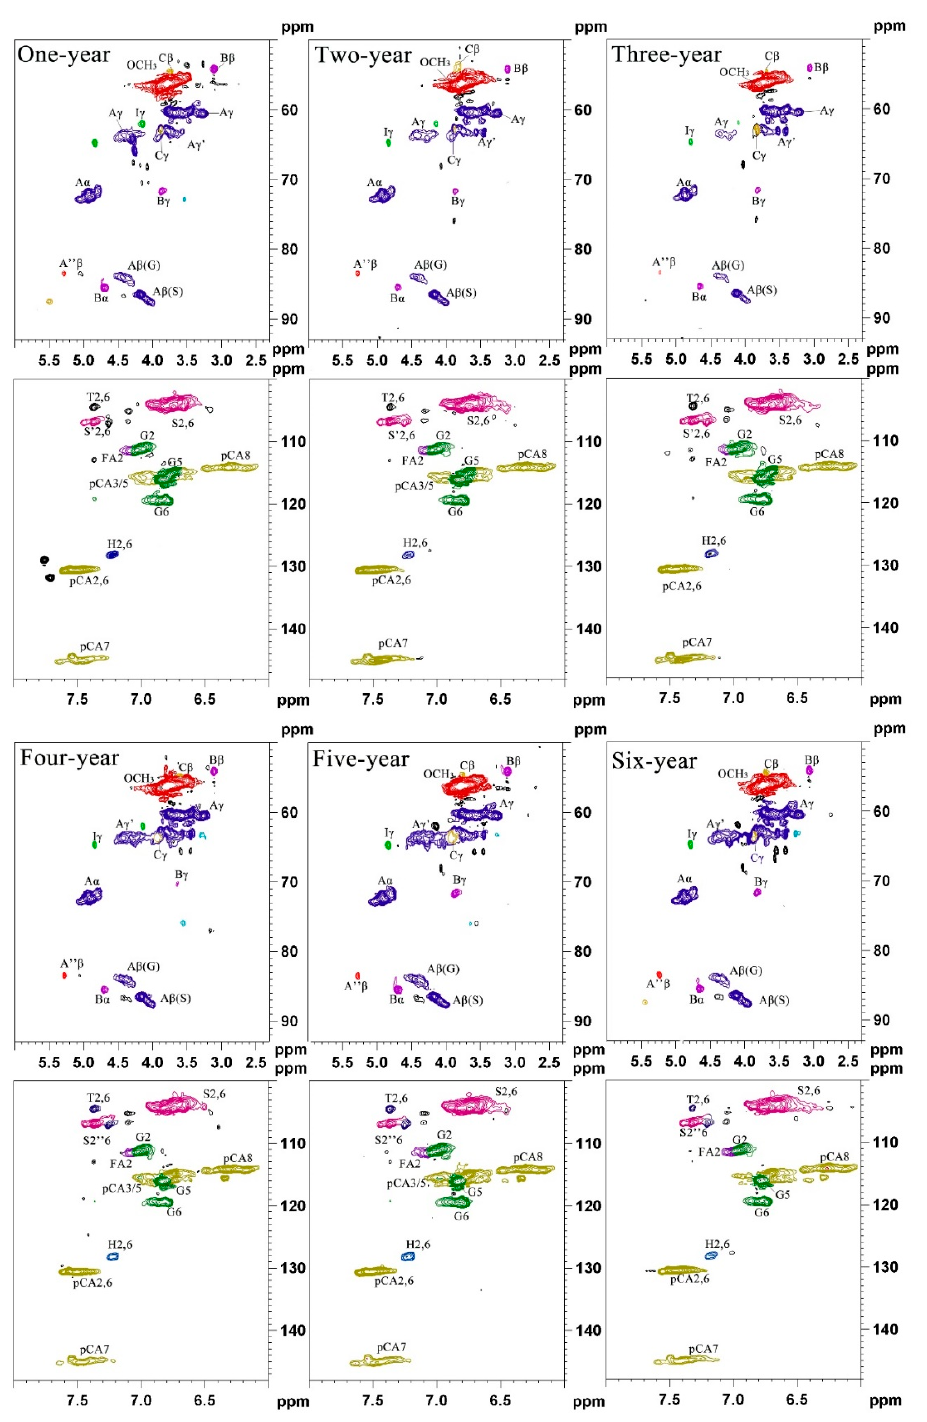
Figure 5. 2D-HSQC NMR spectra of 1–6 year-old bamboo lignins.